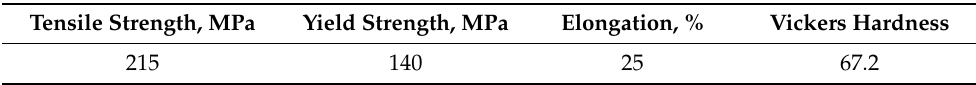
Table 2. Mechanical properties of